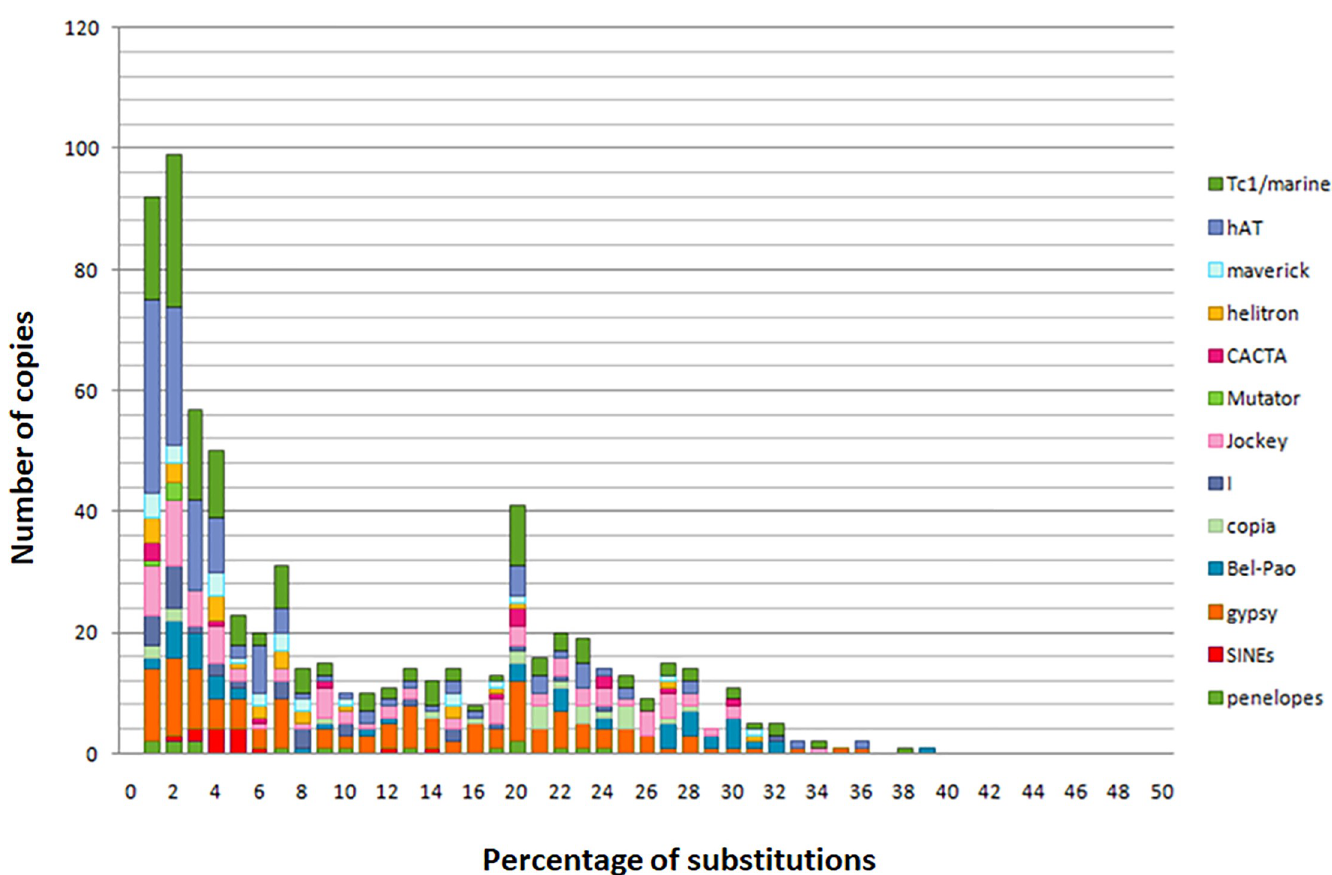
Fig 4. Estimate of TE ages and transposition events in Mayetiola destructor genome. The age of TEs is given as the percentage of substitutions from their consensus sequences shown in the x-axis. Recent events of transposition have low substitution levels. The y-axis shows the TEs’ copy number.